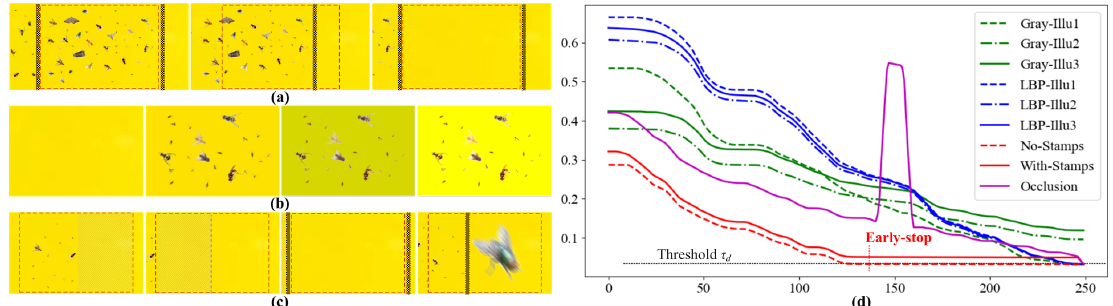
Figure 6. The image analysis for controlling the motor signal. ( a ) The starting, intervening, stopping frames of a simulated video of the replacing process. The red rectangle is the visible monitored area of the e-trap. Its left and right indicate the old and new papers, respectively, which are invisible and protected in the e-trap in practice. The right moving rectangle simulates rolling the paper. ( b ) The reference image I r and starting frames of three videos with different illuminations (Illu1, Illu2, Illu3). ( c ) Special cases for fewer insects on the paper and occlusions caused by a flying insect before the camera. ( d ) The analysis of the replacing processes for different videos. A curve describes the distance variations between I r and frames of a video. If a distance falls below the threshold τ d , the stop signal of the motor is generated. Here, the LBP indicates Local Binary